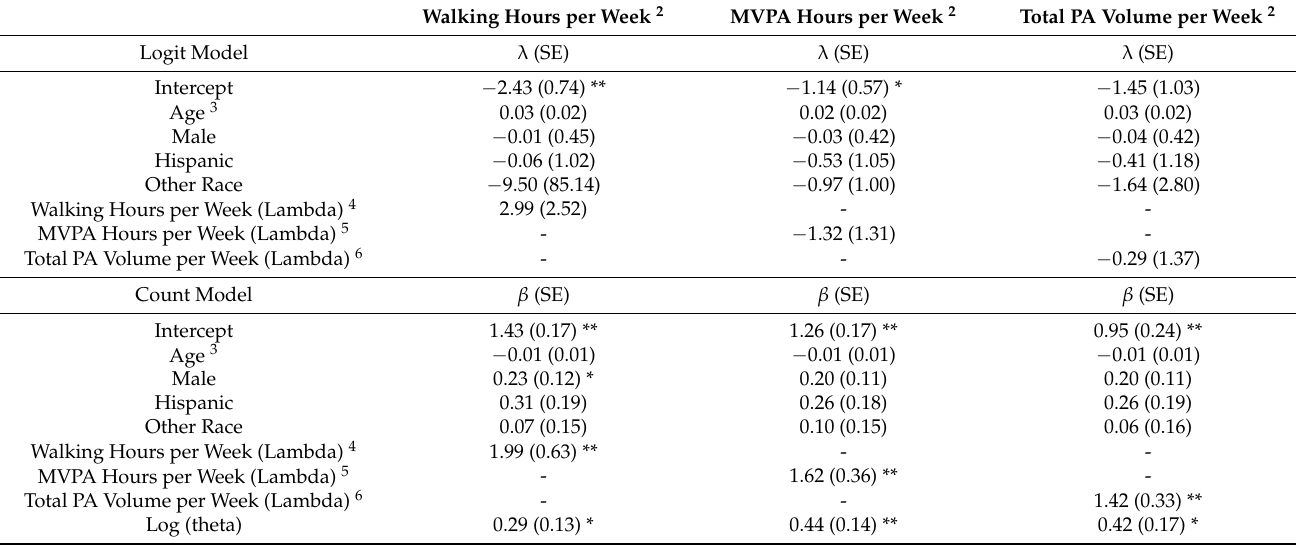
Table 5. Zero-inflated negative binomial models with physical activity intensity and total physical activity volume predicting alcohol servings per week 1